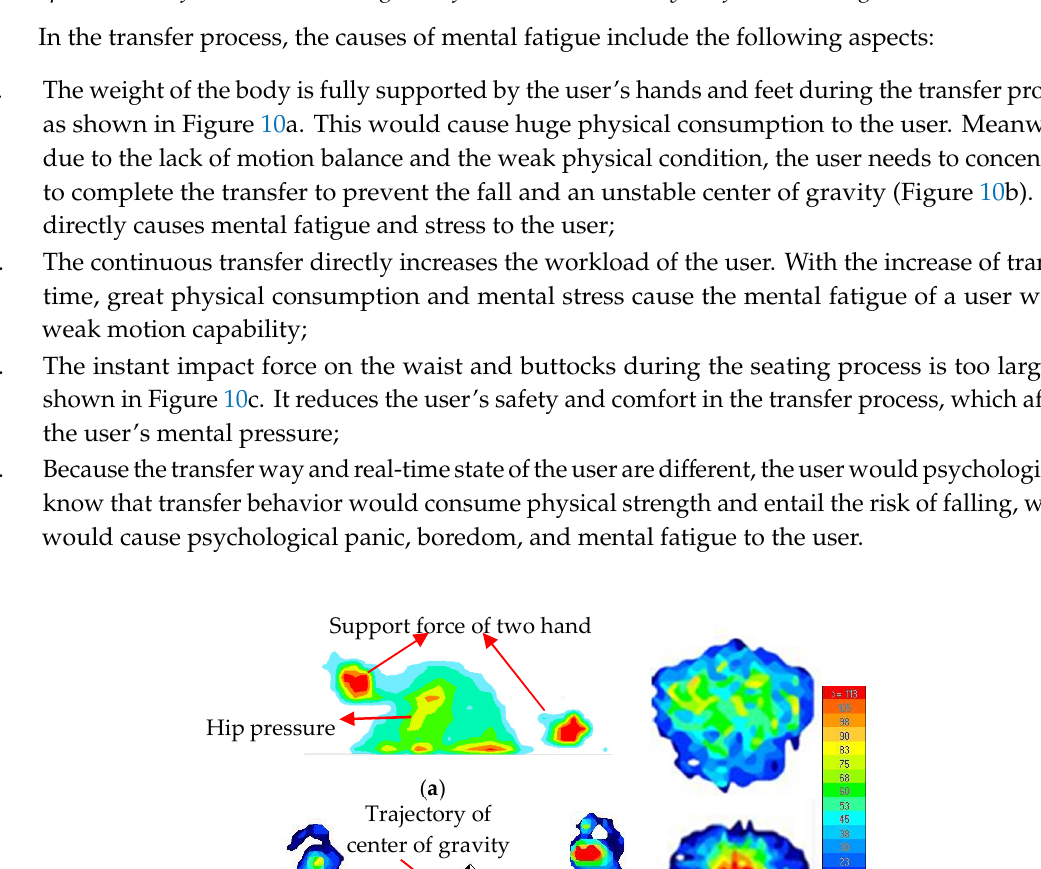
Figure 9. The mean and standard deviation of the error calculated.